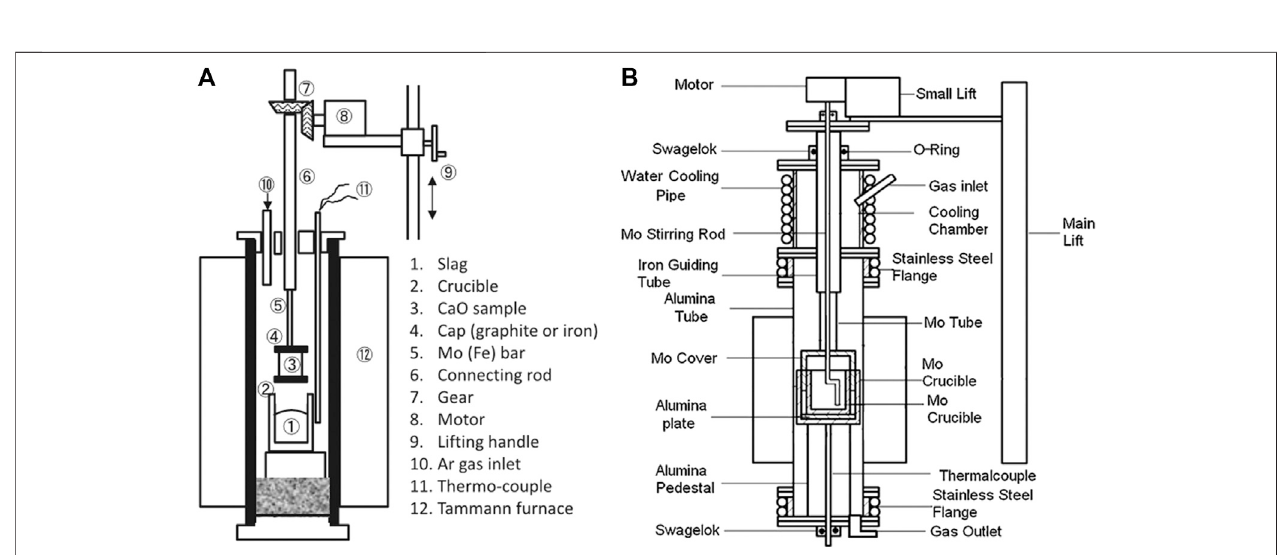
FIGURE 3 | Experimental apparatus to measure the dissolution rate of CaO by (A) (Matsushima et al., 1977) [ Figure 1 of (Matsushima et al., 1977), Copyright The Iron and Steel Institute of Japan] and (B) (Deng et al., 2012) [Figure 9 of (Deng et al., 2012), Copyright WILEY-VCH].